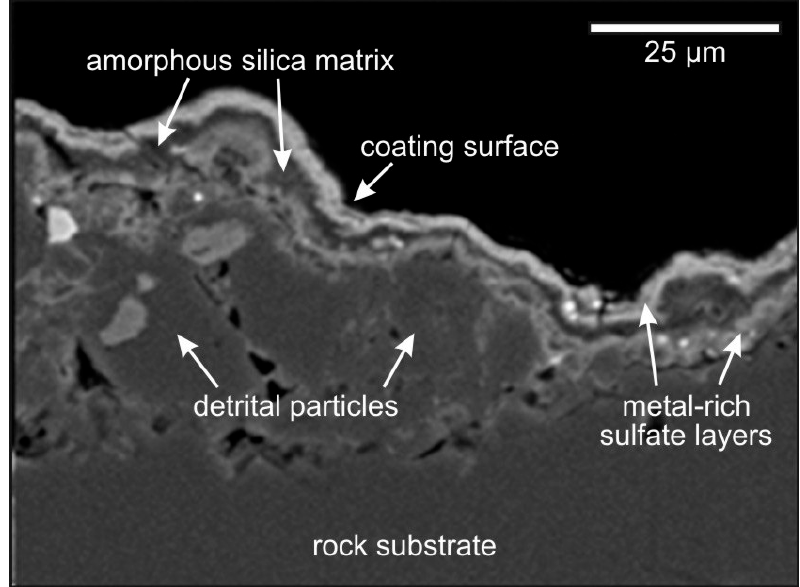
Figure 3. Scanning electron microscope image of a black rock coating associated with materials of the Copper Cliff Formation.